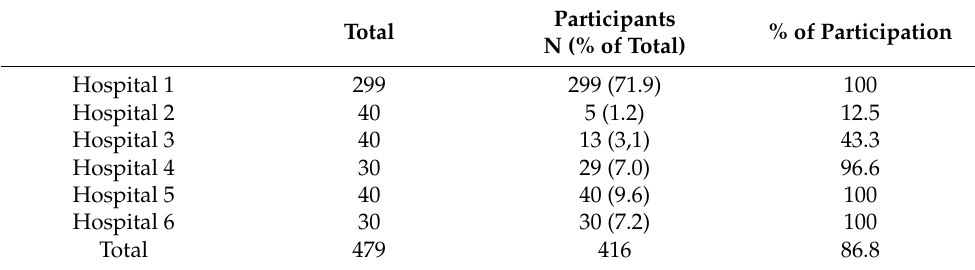
Table 2. Participation rate. Hospital 1: University General Hospital of Alexandroupolis; Hospital